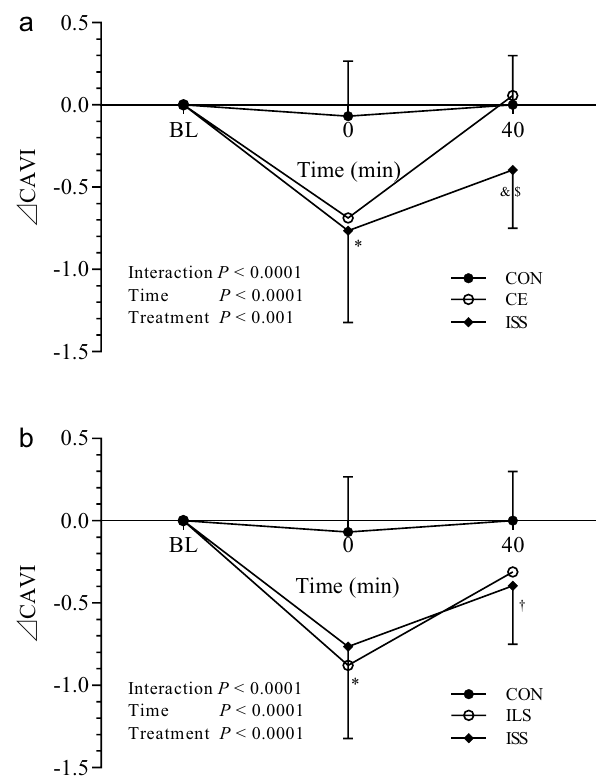
Figure 3. Time course of arterial stiffness response to exercise of different bouts with short interval. Mean (± SD) time-dependent ⊿ CAVI changes in CON, CE, ISS trials ( a ), and CON, ILS and ISS trials ( b ). Statistical analysis was performed using two-factor (treatment and time) repeated measures ANOVA with Bonferroni post-tests. Data are means ± SD, n = 20. * P < 0.0001, CE, ILS and ISS vs. CON at 0 min. & P < 0.05, ISS vs. CON at 40 min. $ P < 0.01, ISS vs. CE at 40 min. † P < 0.01, ISS vs. CON at 40 min.CAVI Cardio-ankle vascular index, BL baseline, CON control, CE continuous exercise, ILL intermittent exercise of long bouts with long interval, ILS intermittent exercise of long bouts with short interval, ISS intermittent exercise of short bouts with short interval.